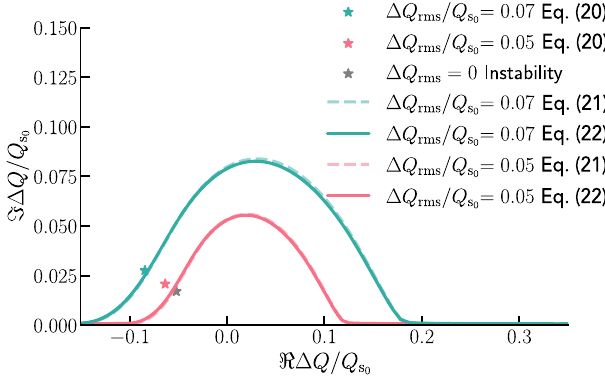
FIG. 11. Stability boundaries for two PEL strengths for the mode l ¼ − 1 (solid and dashed lines, respectively) from Eqs. (21) and (22) and respective coherent tune shifts of the instability (stars) from Eq. (20). Accelerator and beam parameters are the same as in Fig. 9. Two Landau damping strengths Δ Q 0 . 05 ; 0 . 07 g are considered (magenta and cyan =Q rms s 0 ¼ f colors, respectively).